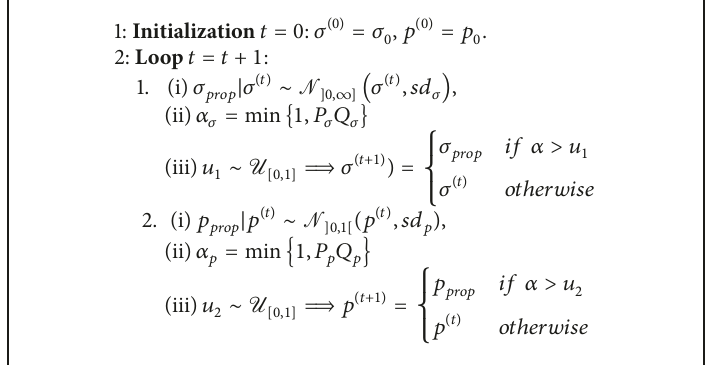
Algorithm 1: Metropolis-Hastings